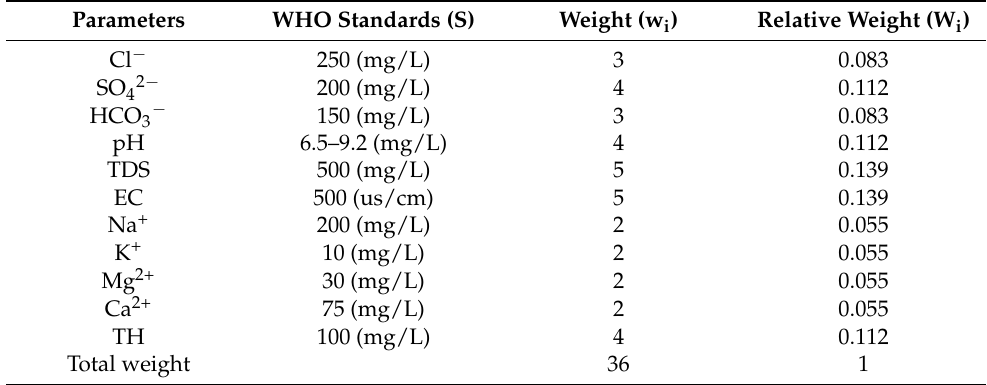
Table 2. The WHO (2011) standards for groundwater quality parameters and the weight values.